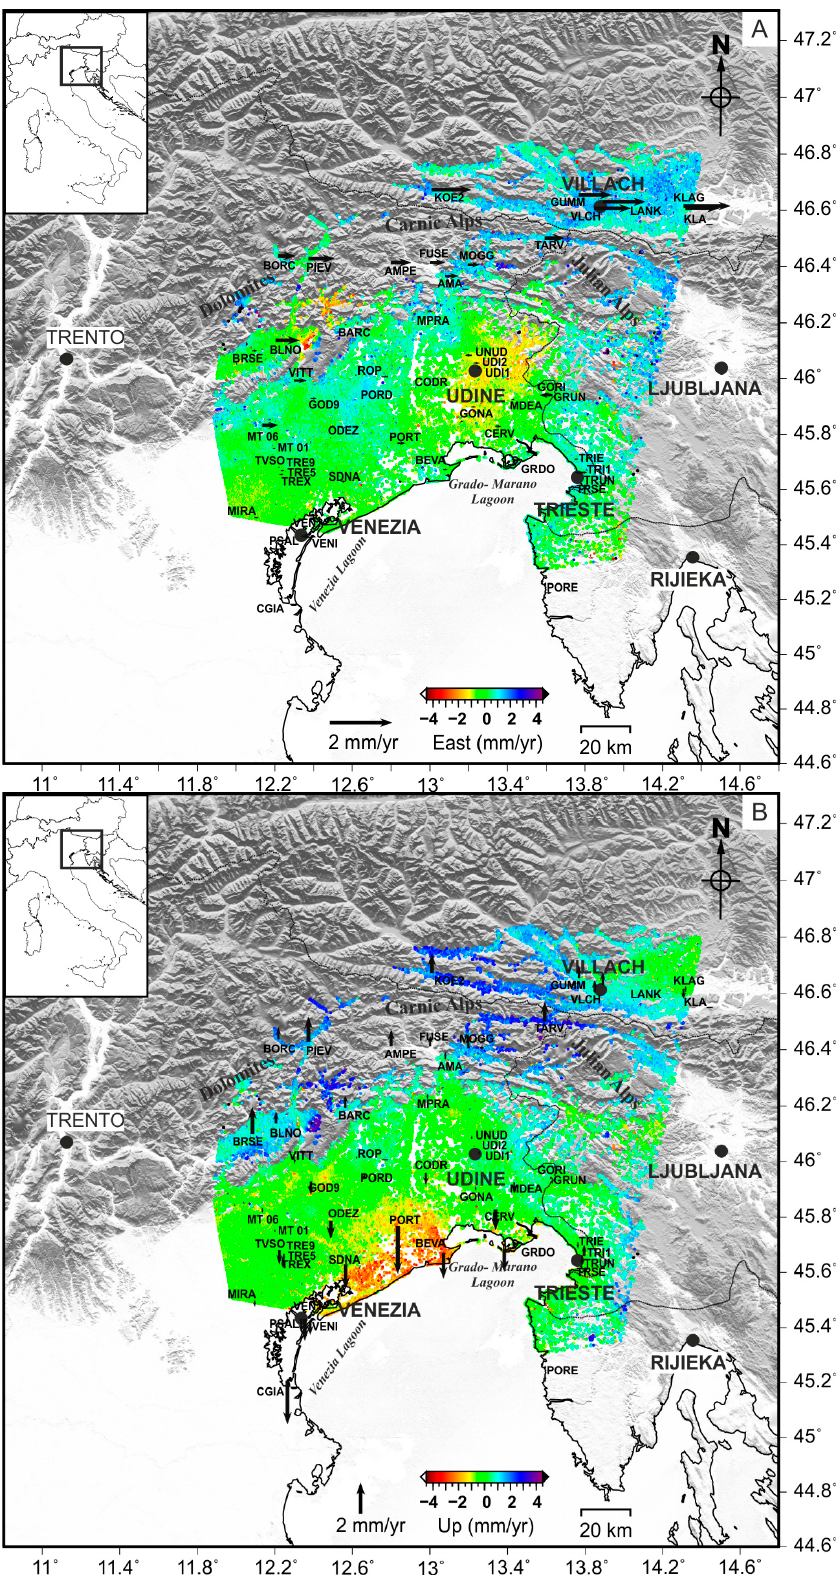
Figure 5. East–west ( A ) and vertical ( B ) velocity maps. The black arrows represent the GNSS horizontal (east–west) and vertical velocity components. According to the scale, positive rates indicate eastward and upward ground motion.